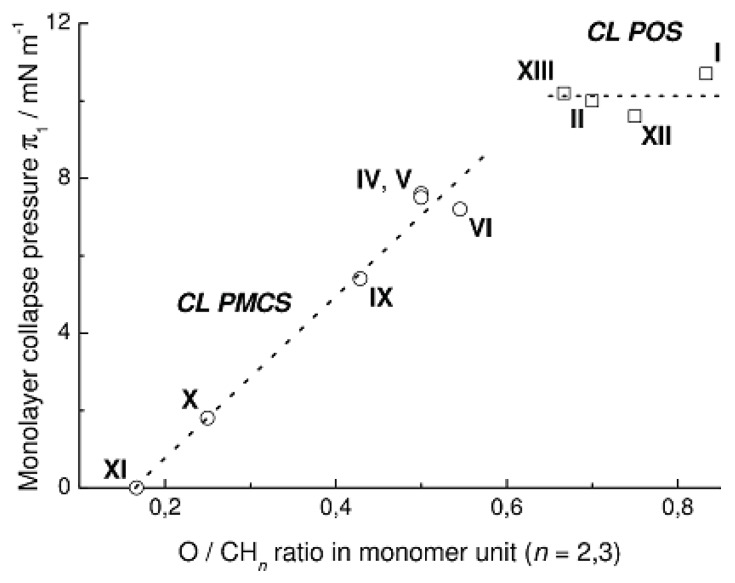
The height of the first step of the surface pressure π1 plotted vs. ratio of the number of hydrophilic to the number of hydrophobic groups in the monomer unit of methyl substituted CL PMCS. For comparison, the π1 values for CL PMS I-Me, II-Me, poly[oxy(2,4,4,6,8,8,10,10-octamethylcyclopentasiloxane-2,6-diyl)] (XII-Me), and poly[oxy(2,4,4,6,6,8,10,10,12,12,14,14-dodecamethylcycloheptasiloxane-2,8-diyl)] (XIII-Me) are shown.